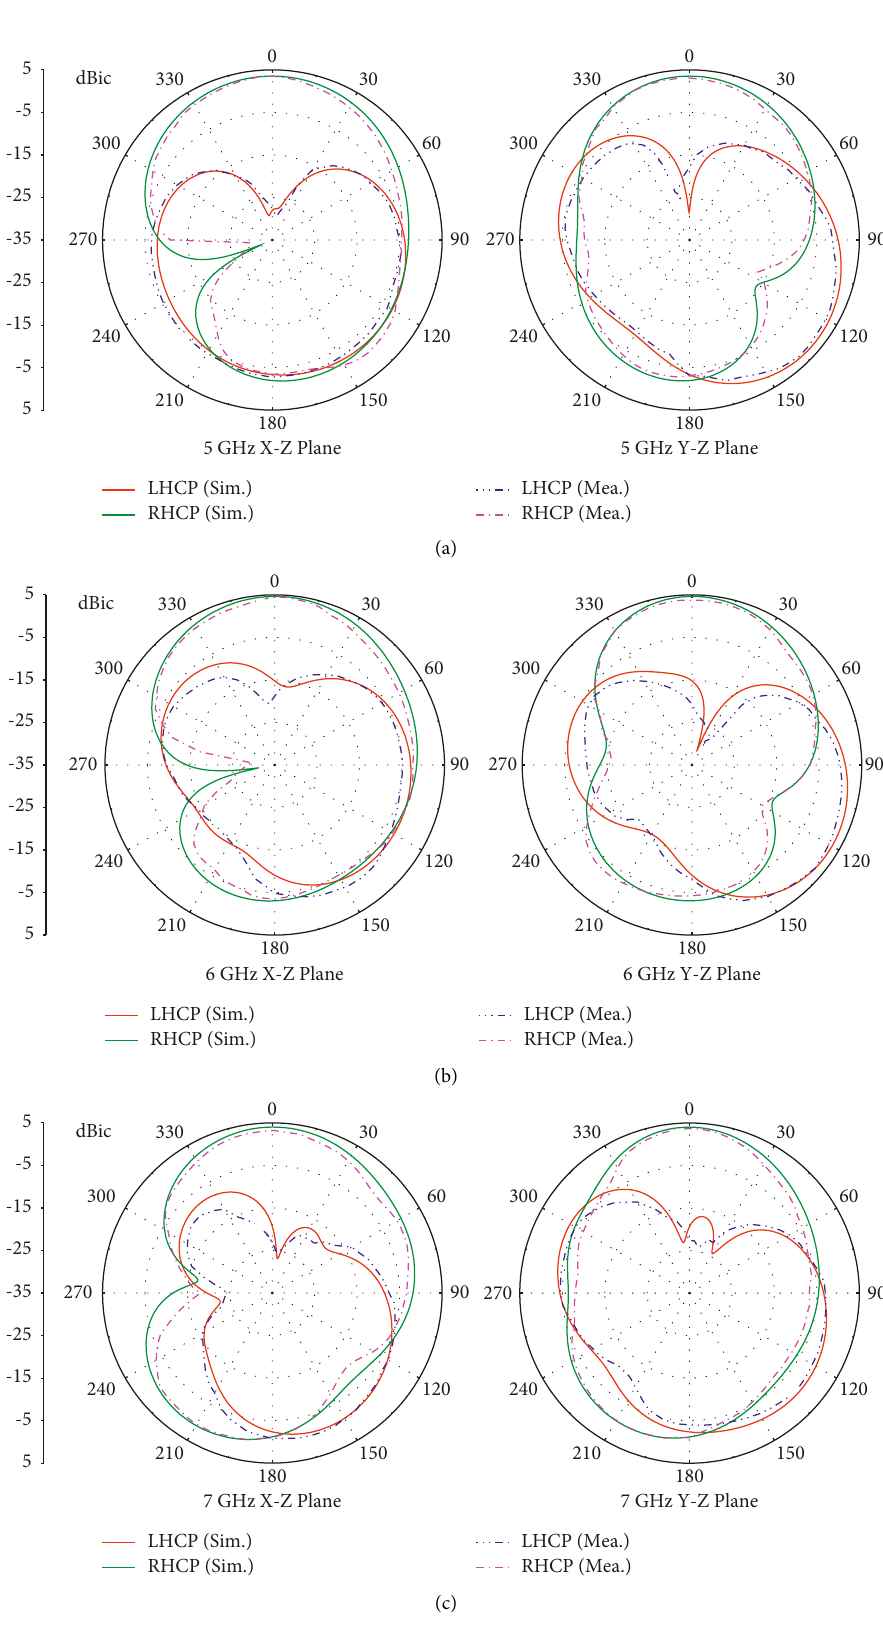
Figure 15: Simulated and measured radiation patterns of An2 at (a) 5GHz, (b) 6GHz, and (c)